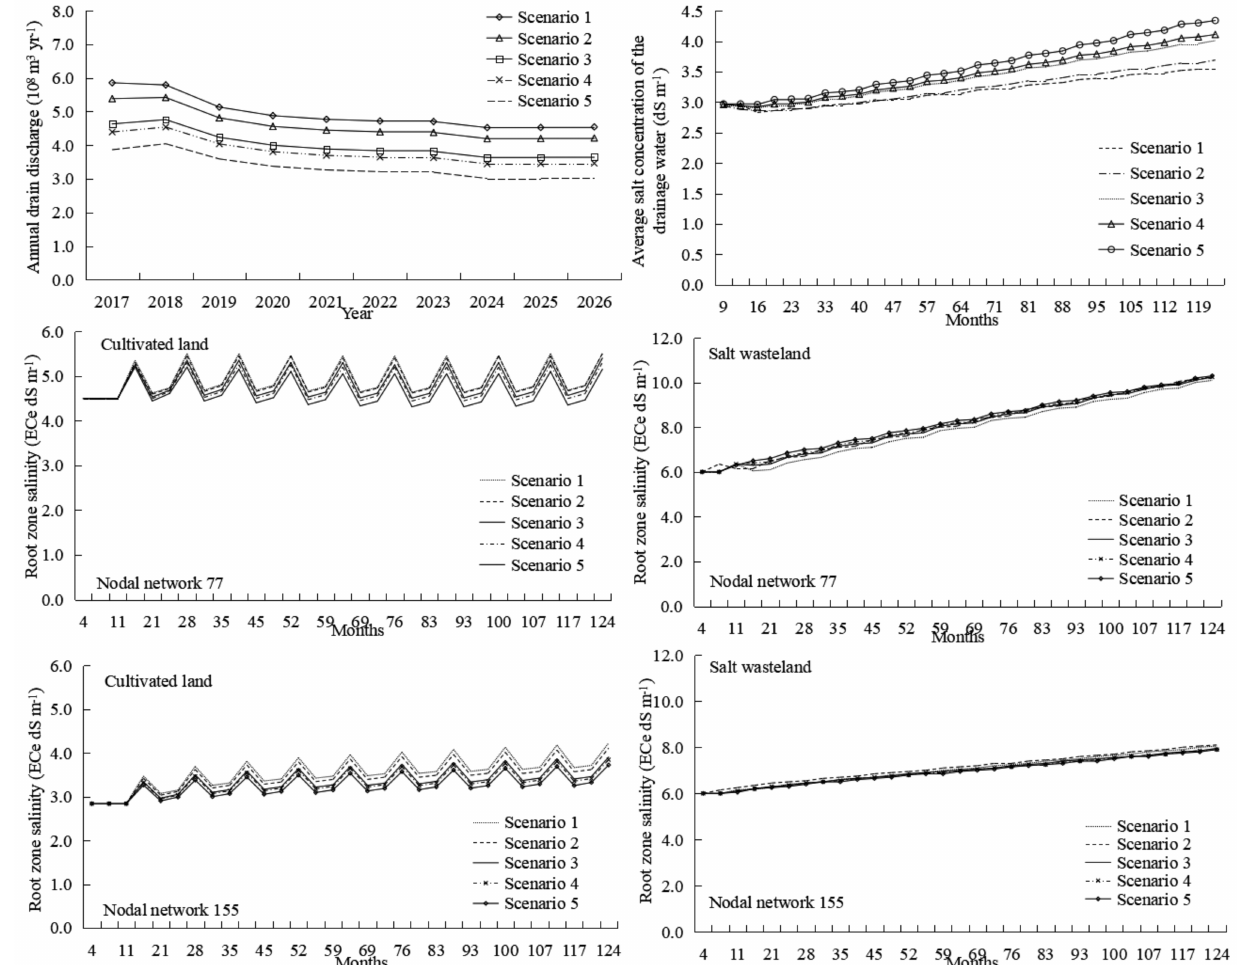
Figure 10. Variation of the annual drain discharge, drainage water salinity, and soil salinity dynamics of cultivated land and salt wasteland under different water-saving